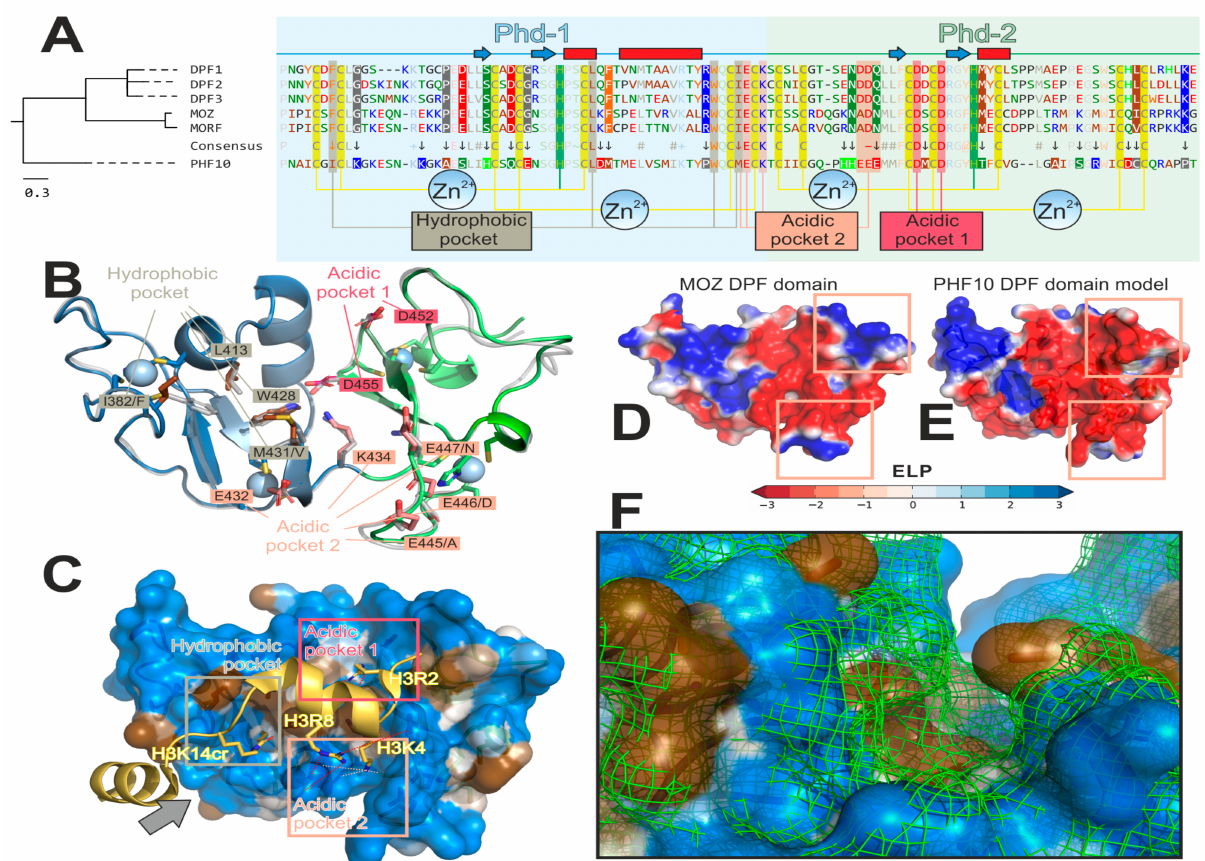
Figure 3. PHF10 DPF domain has a number of peculiarities compared to other DPF-domain proteins. ( A ) Amino acid (a.a.) comparison suggests an early evolutionary divergence of PHF10. Left: phylogenetic tree for six DPF-domain-containing proteins: MOZ and MORF histone acetyltransferases; DPF1–3 and PHF-10 chromatin remodeling complex subunits. Right: corresponding a.a. alignment formatted for better visualization of PHF10 peculiarities. PHD-1 and -2 comprising DPF- domain have light blue and light green background , respectively. Secondary structure (determined for MOZ structure (Pdb ID: 3V43) [38]) is shown above the sequences ( blue arrows for β -strands and red rectangles for α -helices). A.a. are colored and grouped according to properties: blue (“+”)—positively charged [Lys, Arg]; red (“ − ”)—negatively charged [Asp, Glu]; green (“~”)—polar [Ser, Thr, Asn, Gln]; bright-green —His; brown (“#”)—aliphatic [Ala, Val, Leu, Ile, Met]; orange —aromatic non-polar [Phe, Tyr, Trp]; black —Cys, Gly and Pro. Zn 2+ -binging sites (two per one PHD module) are shown as yellow (Cys) and green (His) vertical stripes . A consensus line is shown between PHF10 and five other sequences. The 100%-conserved positions (with respect to the aforementioned a.a. groups) are pale (except Zn 2+ -binding sites and histone-binding pockets). The marked dissimilarity in the PHF10 sequence as opposed to the five other proteins is designated by an arrow and a coloured background (depending on the a.a. group) for PHF10 and other proteins (if conserved in all five resting sequences). Three histone-binding pockets are annotated and designated with vertical stripes: 1) hydrophobic (binds non-polar lysine modifications: H3K14ac/cr/bu in MOZ; H4S1-Nac or H4K16ac in DPF3); acidic-1 (100% conserved; anchors H3R2 in MOZ or H4R17 in DPF3); and acidic-2 (binds unmodified H3K4 or H4K20; and anchors H3R8). B–F: Homology model of PHF10 visualizes its peculiarities in 3D (in comparison with MOZ, which was a structural template for MODELLER 9.19). ( B ) Overview of a model. PHD-1 and -2 are blue and green , respectively. Parent MOZ structure is shown as a semi-transparent gray cartoon . Residues of the four Zn 2+ -binding sites are represented as sticks and ions as spheres . Residues of the three histone-binding pockets are annotated ; corresponding MOZ residue is typed after a slash, if different. Note the dissimilarities in the hydrophobic and acidic-2 pockets, which may determine PHF10 specificity. ( C ) A visualization of how PHF10 might bind the H3 tail (based on the MOZ/H3K14cr complex (Pdb ID: 5B76) [13]). PHF10 model is shown with a semi-transparent surface colored as a gradient from blue (polar) to brown (non-polar) according to MHP scale [45,46]; the peptide is colored gold . Binding pockets are shown with rectangles : hydrophobic binds non-polar H3K14cr; acidic-1 anchors H3R2 via a